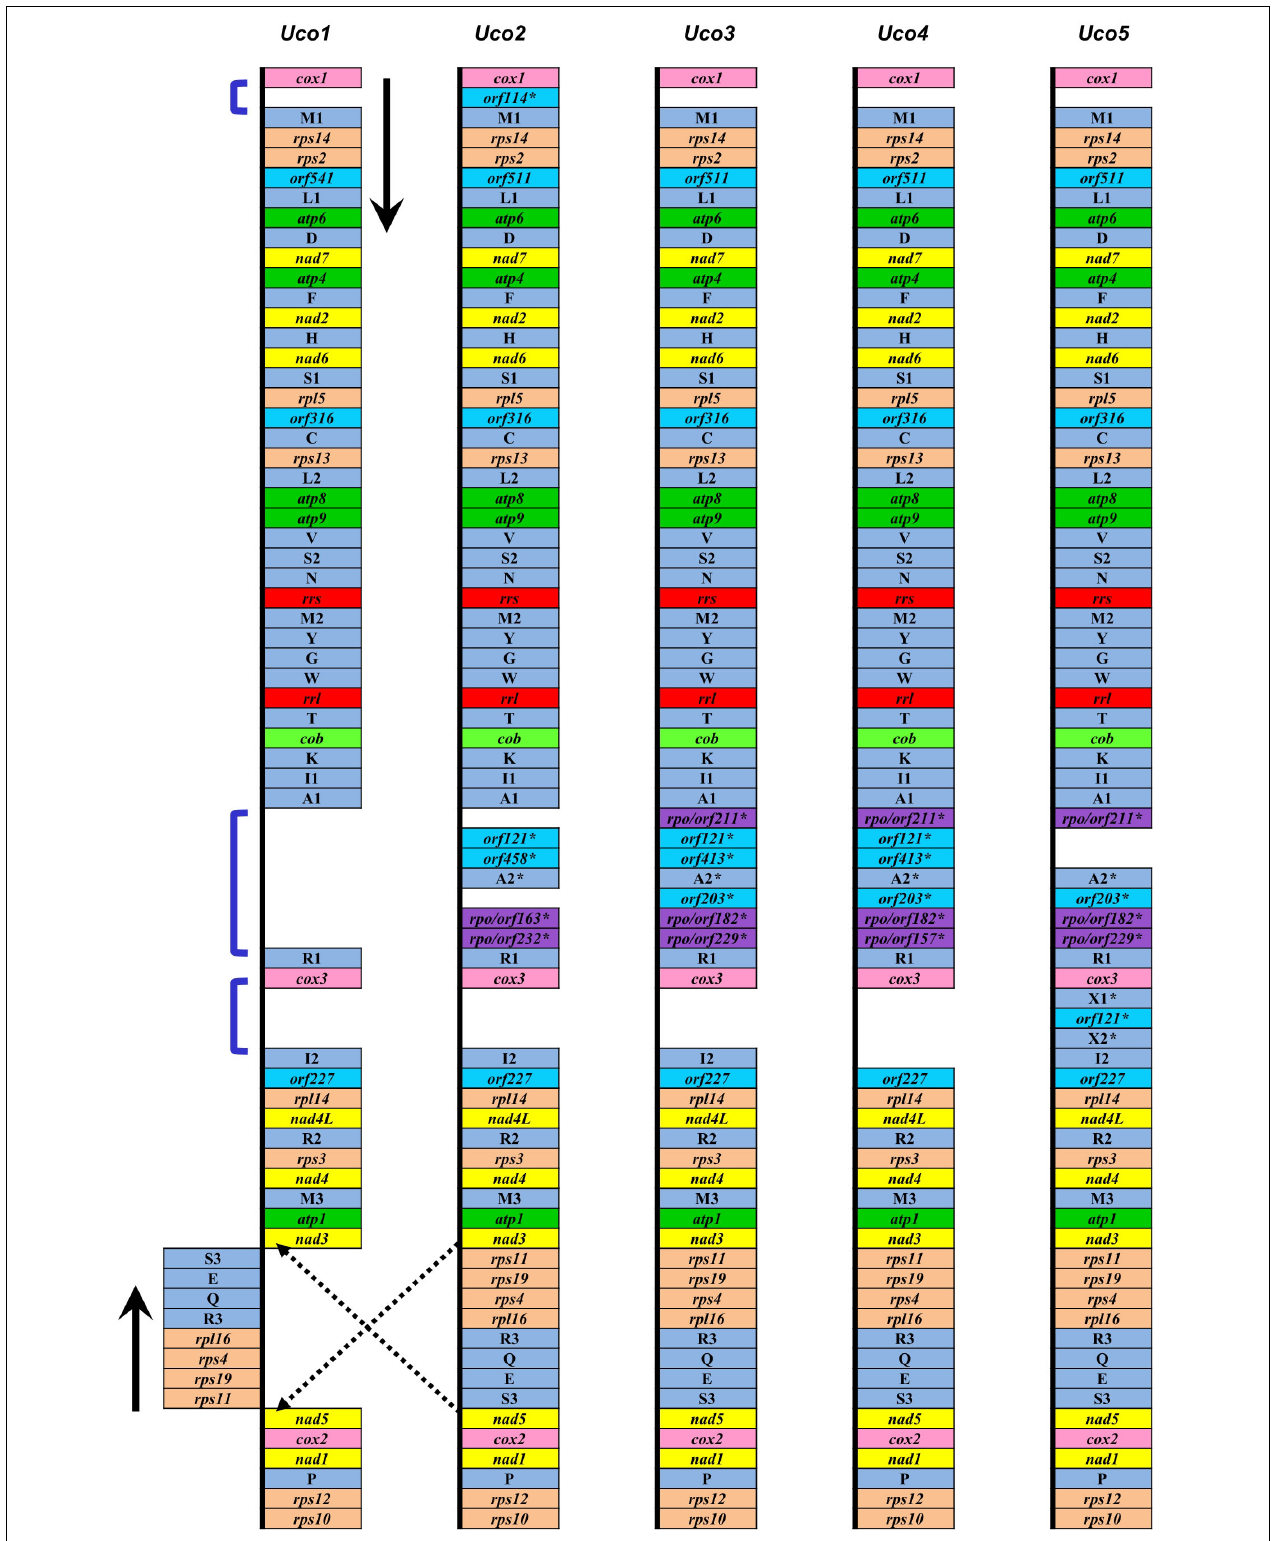
FIGURE 3 | Comparison of genome organization and gene order of five U. compressa mitogenomes. The dark blue brackets showed three intergenic regions with the genome-specific tRNAs and orf s, which were indicated by an asterisk ( ∗ ).